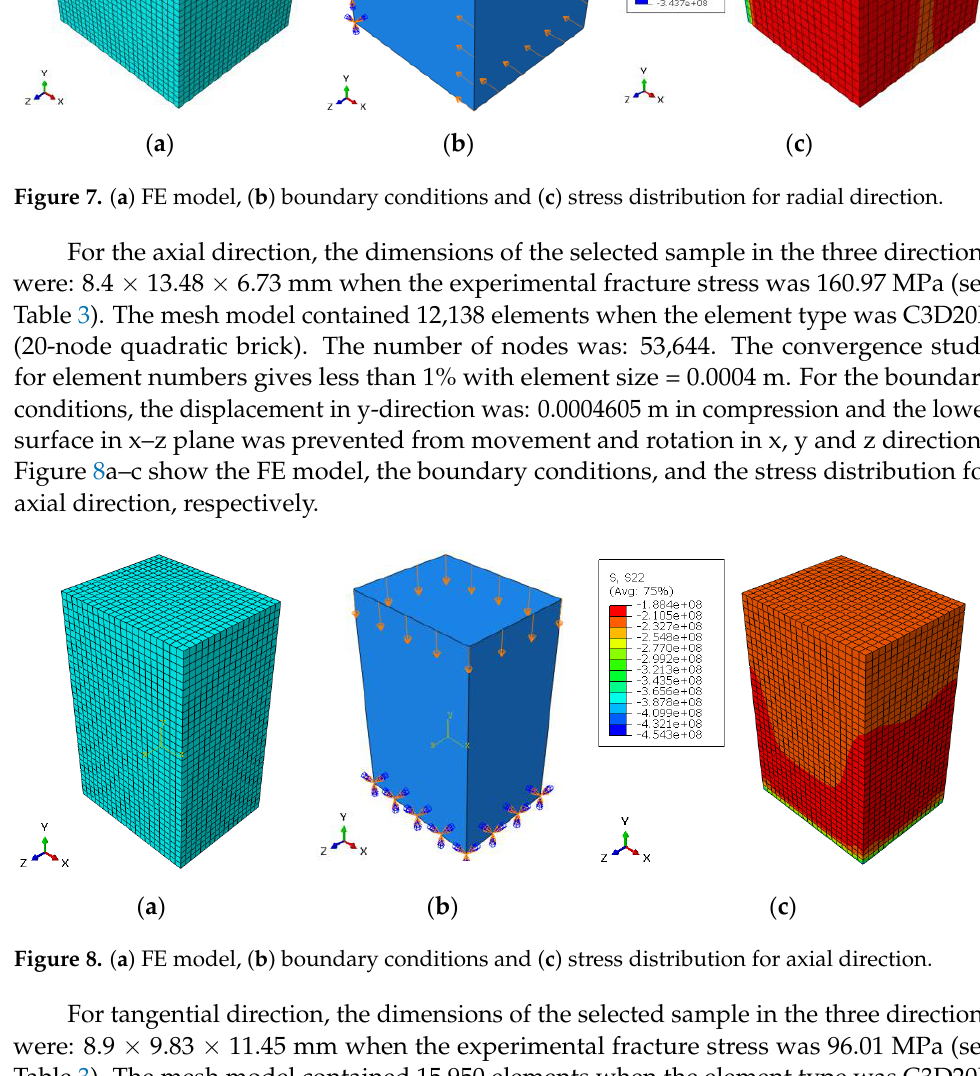
Table 3. Experimental values of fracture stress at